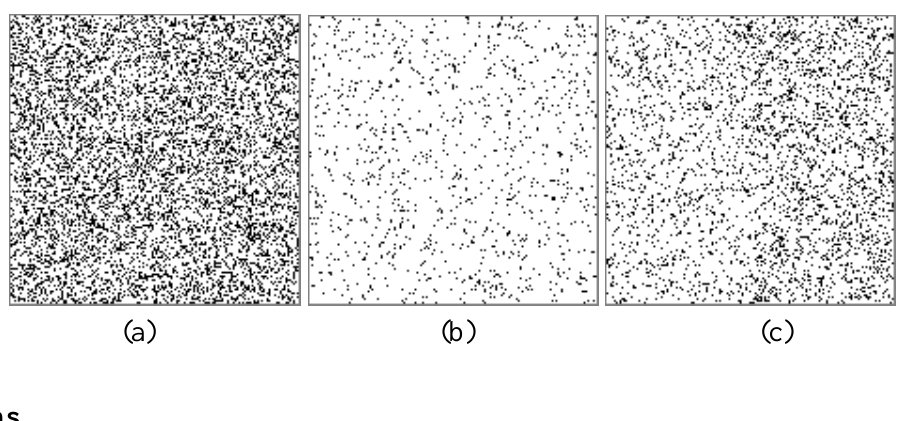
Figure 9. (a) The residue point map in HH channel with strong noise ( 1 m = ). (b) The residue point map of the phase obtained by the AO method in the ML case. (c) The residue point map of the phase obtained by the CO2 method in the ML